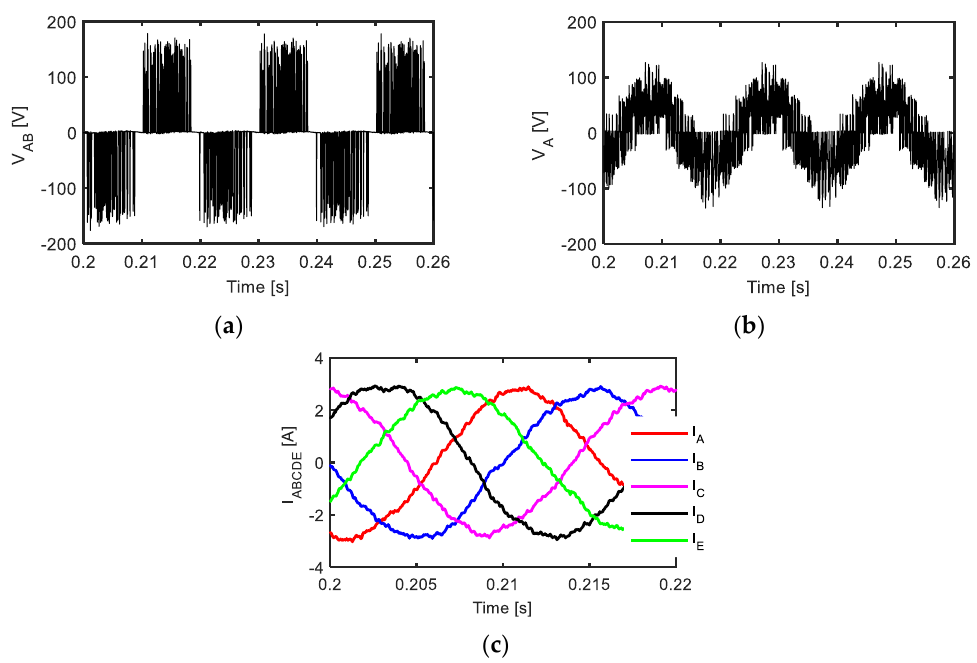
Figure 14. Measured ( a ) line output voltage, ( b ) phase output voltage, and ( c ) phase output current at 1500 rpm.